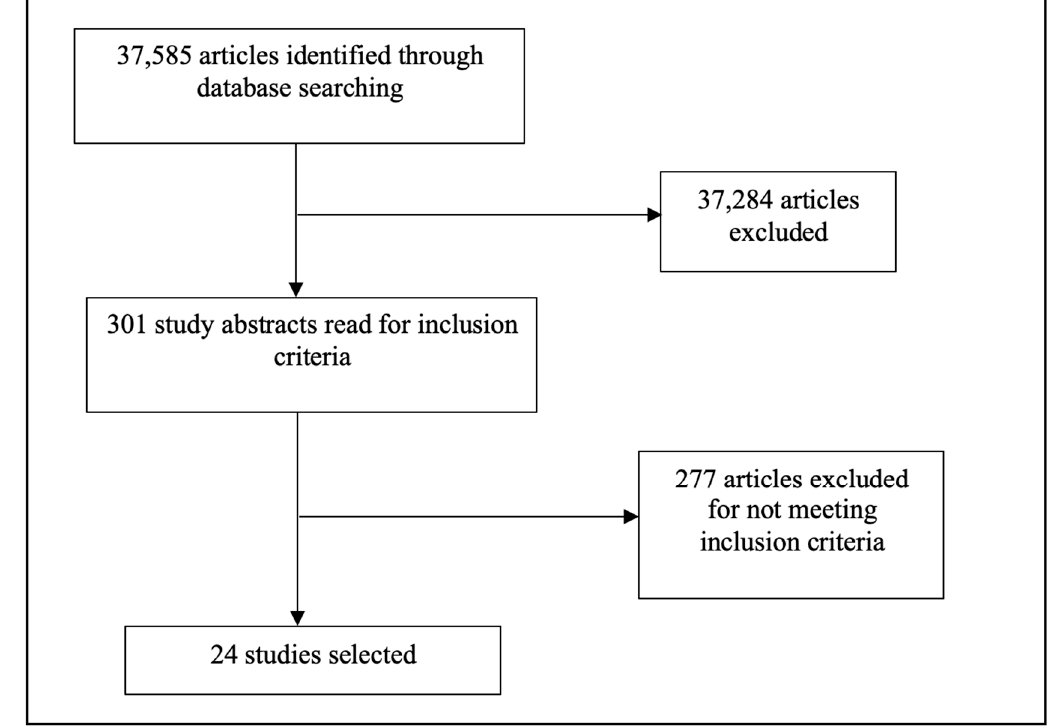
Figure 1. Flowchart depicting a summary of searches and results for scoping review. Table 1. Characteristics of included items for scoping review organised by theme.